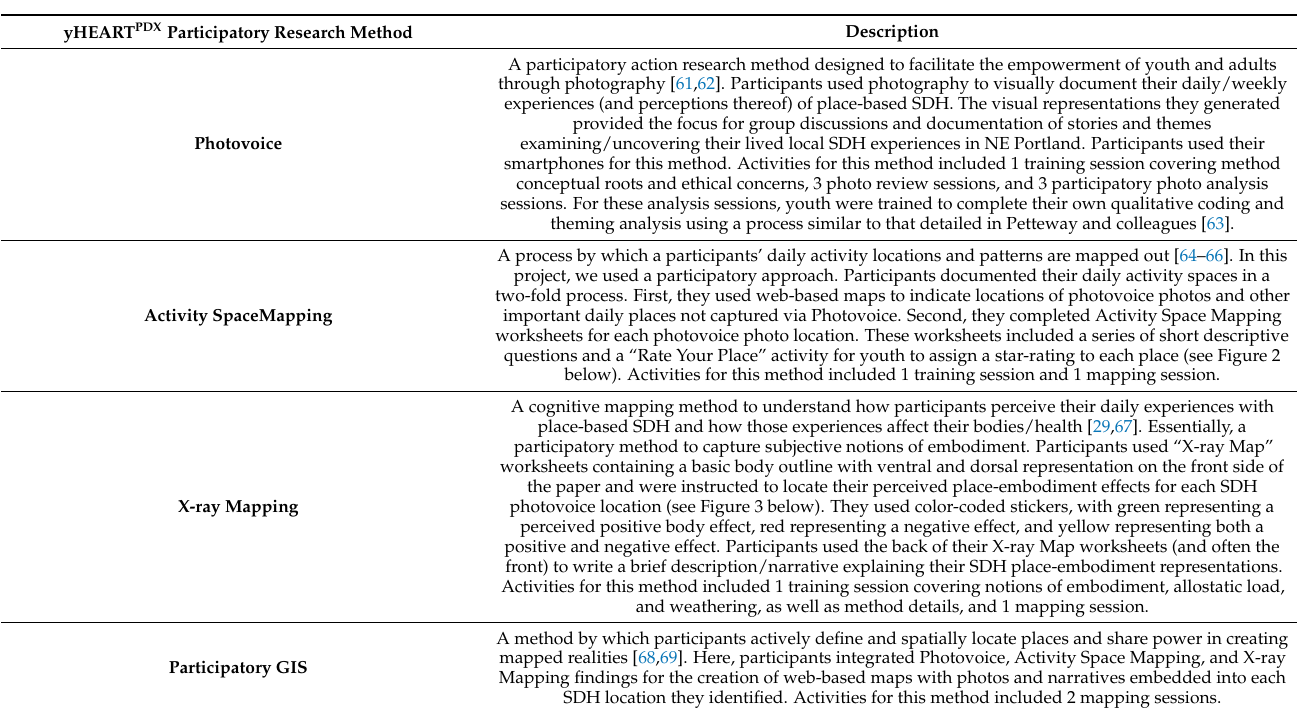
Table 2. Summary of participatory research methods used by yHEART PDX youth researchers.